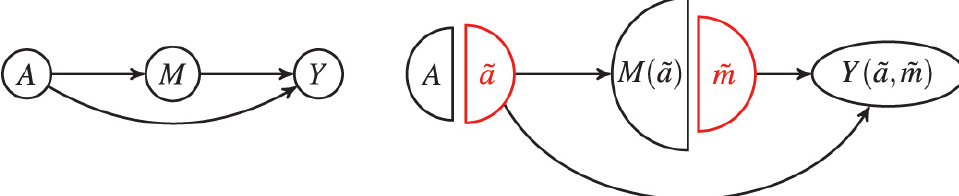
Figure 1: (A) The three-node mediation directed acyclic graph in a setting with no confounding. The nodes represent ran- dom variables, and the arrows represent possible causal effects of one random variable on another. (B) The single-world intervention graph in the setting of (A) under the intervention setting u to ̃u and u to ̃u . The black nodes represent ran- dom variables under this intervention, the red nodes represent the level an intervened random variable takes under this intervention, and the arrows represent possible causal effects of one variable under this intervention on